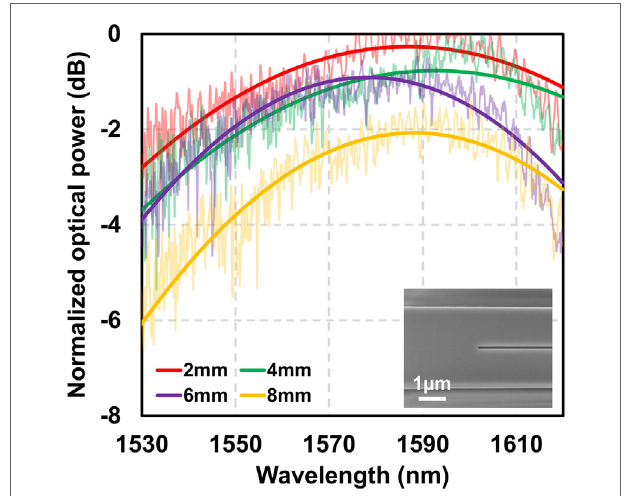
FigUre 4 | spectrum and quadratic function fitting for different waveguide lengths with slot width of 100 nm . The inset shows the coupling region between the strip region and the slot region of the